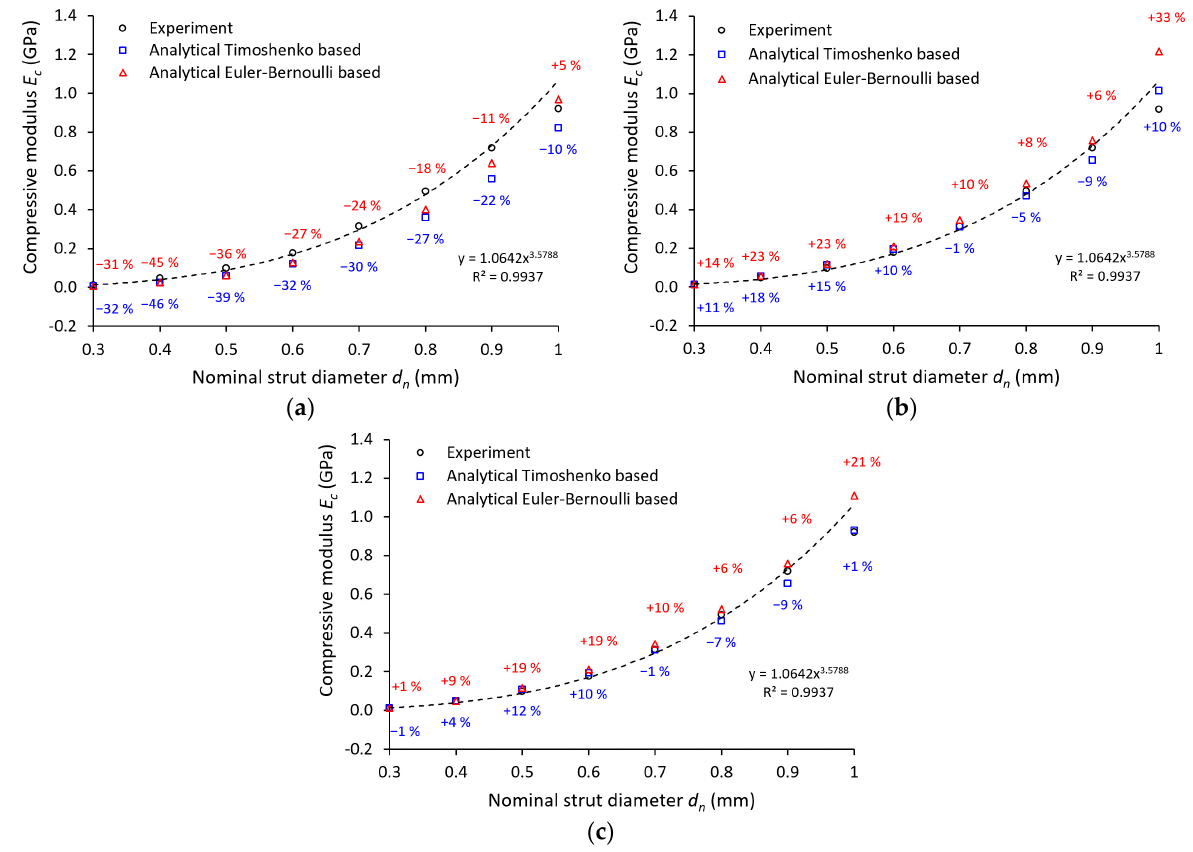
Figure 11. Comparison of quasi-static compression experiment with an analytical approach for: ( a ) nominal strut diameter; ( b ) Gauss circular approximation; ( c ) elliptical approximation.